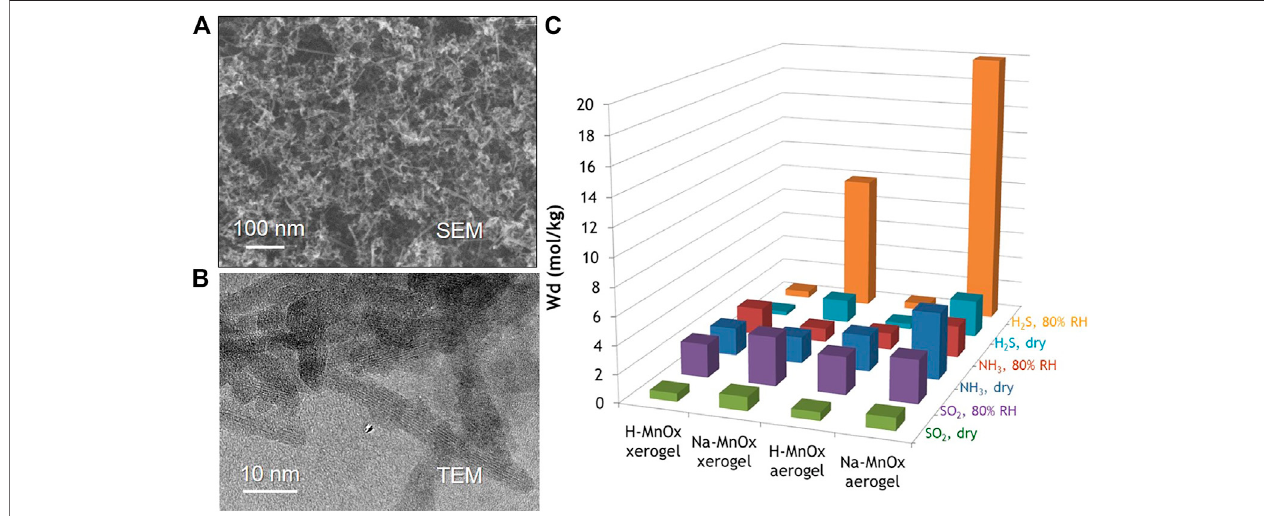
FIGURE6|(A) SEMand (B) TEMofMnO x aerogels.AdaptedfromLongetal.(2016)withpermissionfromtheAmericanChemicalSociety. (C) ComparisonofH 2 S, NH 3 , and SO 2 uptake under dry and humid